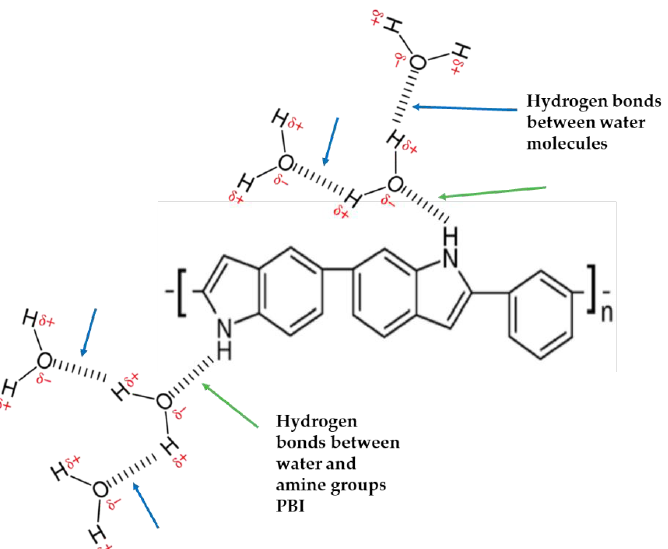
Figure 3. PBI structure with hydrogen bonds (an amine group and water molecules) and hydrogen bonds (two water molecules). Modified from [66].